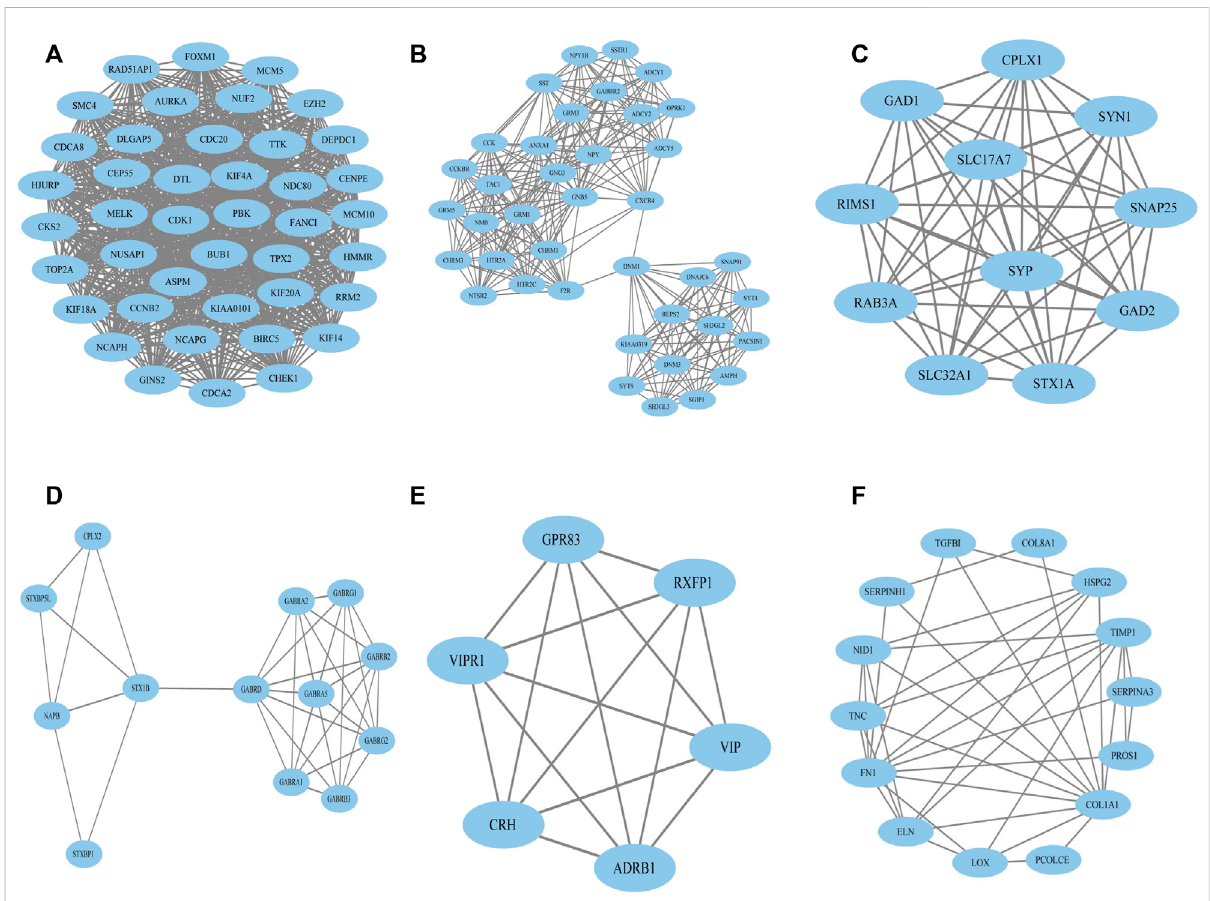
FIGURE 3 TopsixprimarymodulesofPPIsub-networksfromtheMCODEinCytoscape software. (A) Module1; (B) module2; (C) module3; (D) module4; (E) module 5; (F) module 6. PPI: protein – protein interaction; MCODE: Molecular Complex Detection.